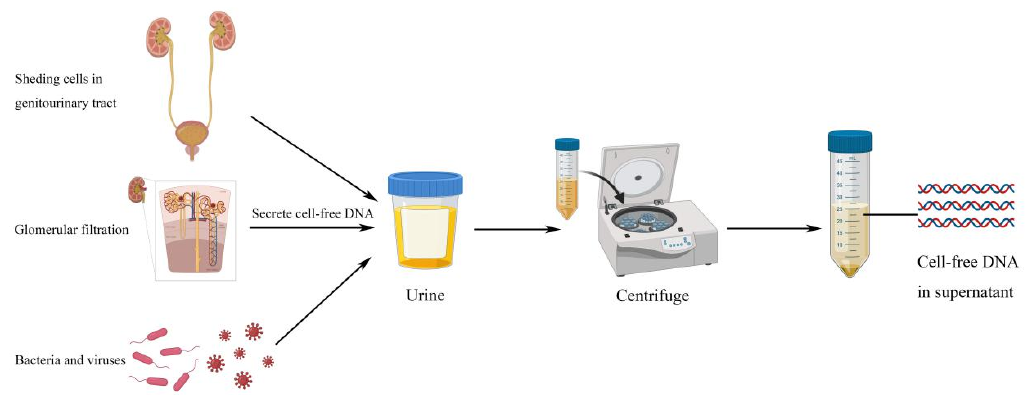
Figure 1. Urinary cell-free DNA can come from shedding cells in genitourinary tract, glomerular filtration process, and infecting bacteria or viruses in urogenital tract. Then, after centrifuging, researchers can get cell-free DNA in urine supernatant.